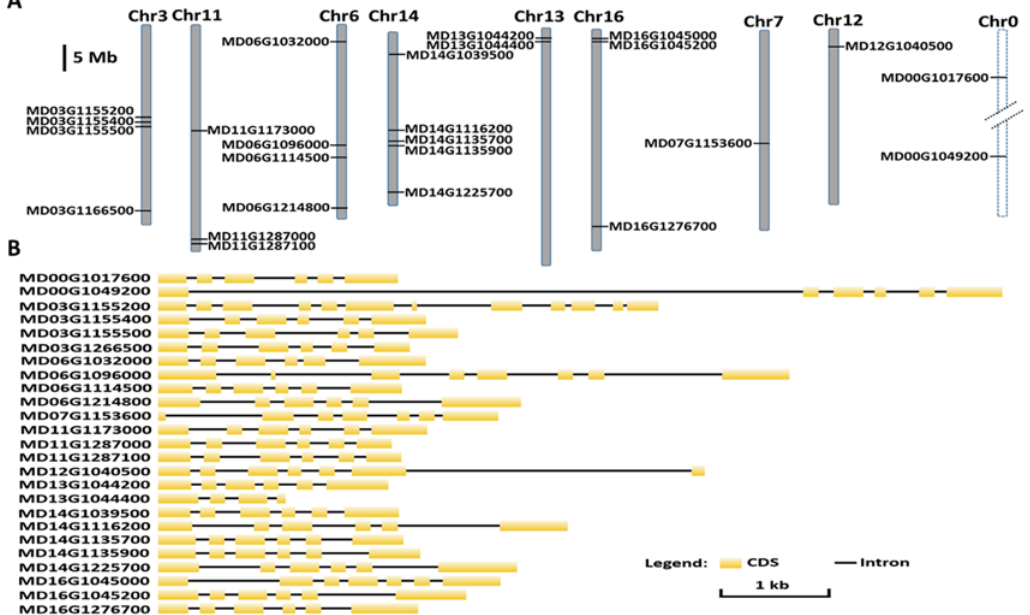
Figure 1. Genes encoding aluminum-activated malate transporter ( ALMT ) in the apple genome. ( A ) Chromosomal location of apple ALMT genes. The dashed line indicates the unanchored sequences; ( B ) genome organization of apple ALMT genes. Yellow indicates exons; black line indicates introns.